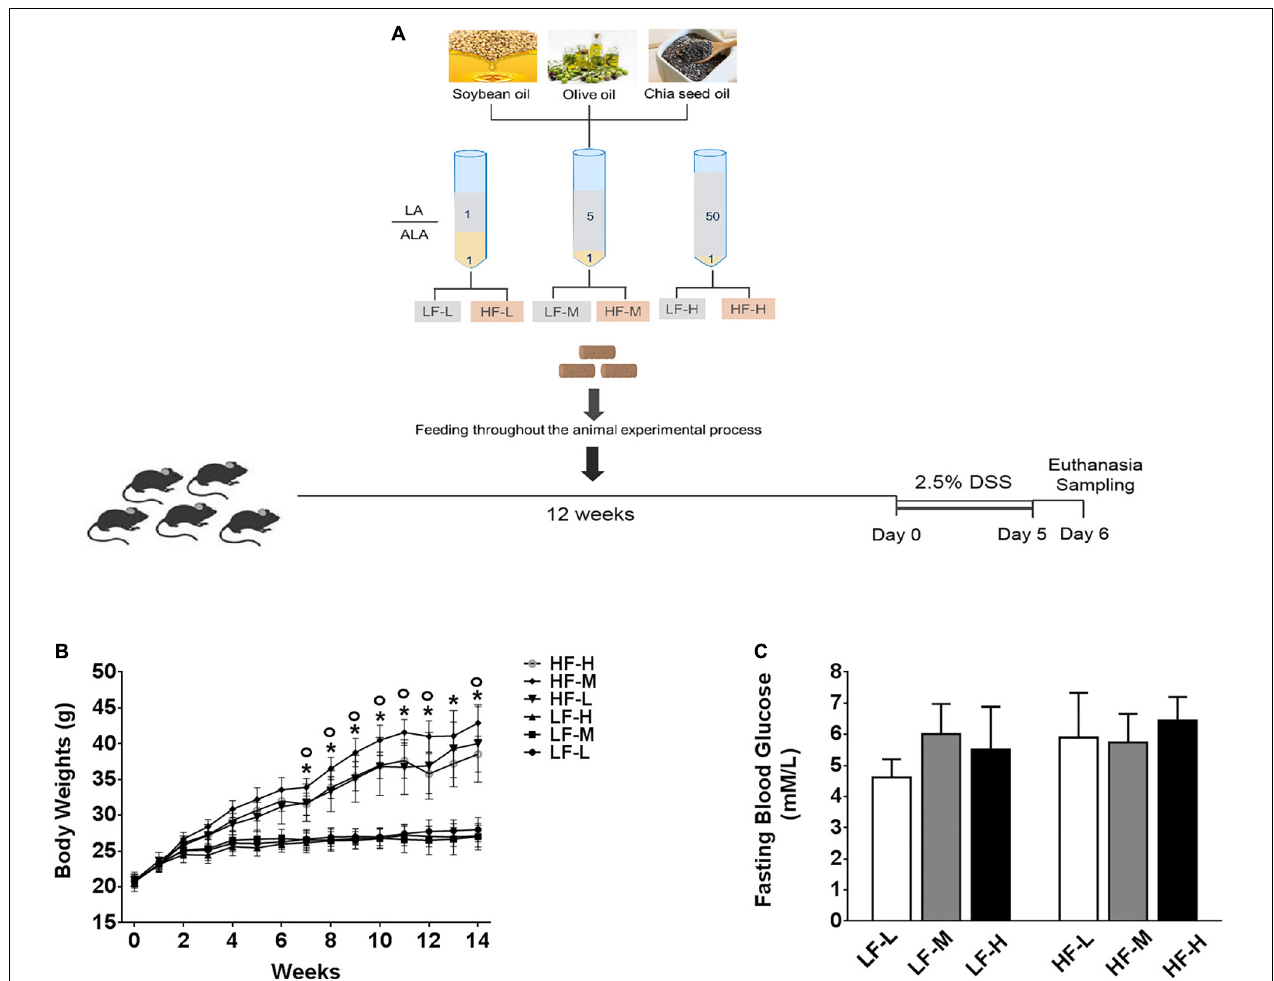
FIGURE 1 | (A) Illustration of experimental design and basic indices of mice during 3 months on different diets. (B) Curve of changes in body weights. (C) Fasting blood glucose levels after 3 months feeding on different diets. Asterisk indicates a significant difference between the high-fat diet groups and low-fat diets (LF-L + LF-M + LF-H vs. HF-L + HF-M + HF-H) and circle indicates a significant difference between the HF-M and other high fat diet